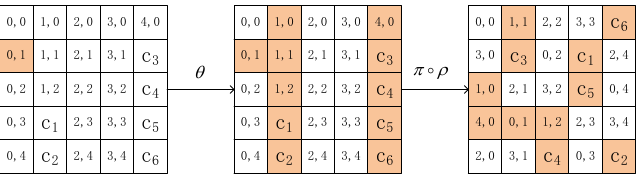
Figure 7: Diffusion of the 16-bit Keys in A [0 , 1] and 64-dimension Cube